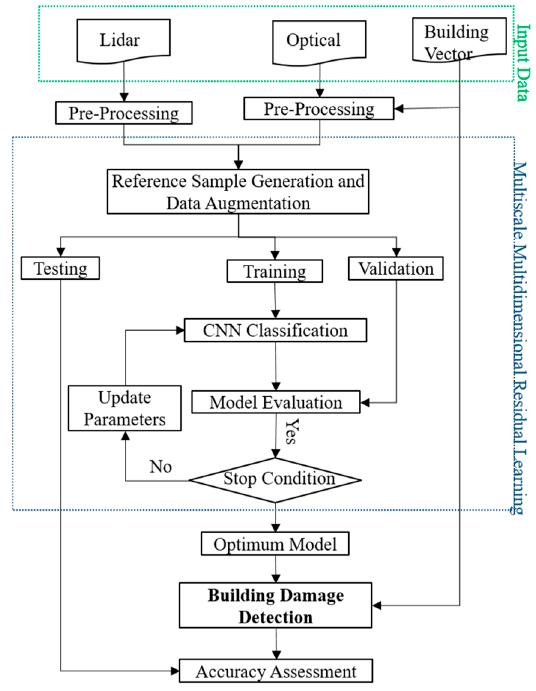
Figure 4. Flow of the proposed building damage detection (BDD) method.